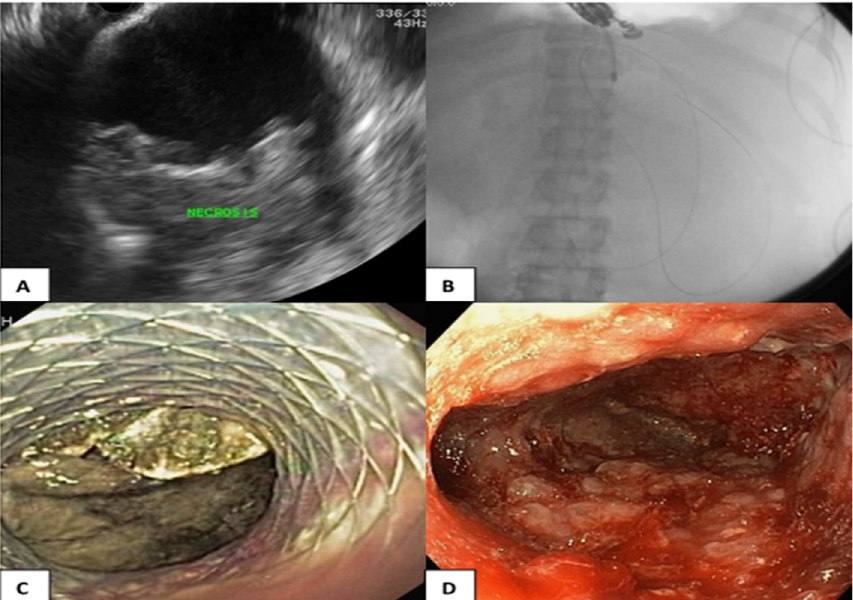
Figure 2. ( A ) Endosonographic view of the WON; ( B ) The A guidewire and a cystotome catheter (cautery method) advancing into the WON; ( C ) LAMS was placed between the gastric lumen and the collection for ETD; ( D ) DEN was performed repeatedly until pink granulation tissue was demonstrated in the wall of the collection.